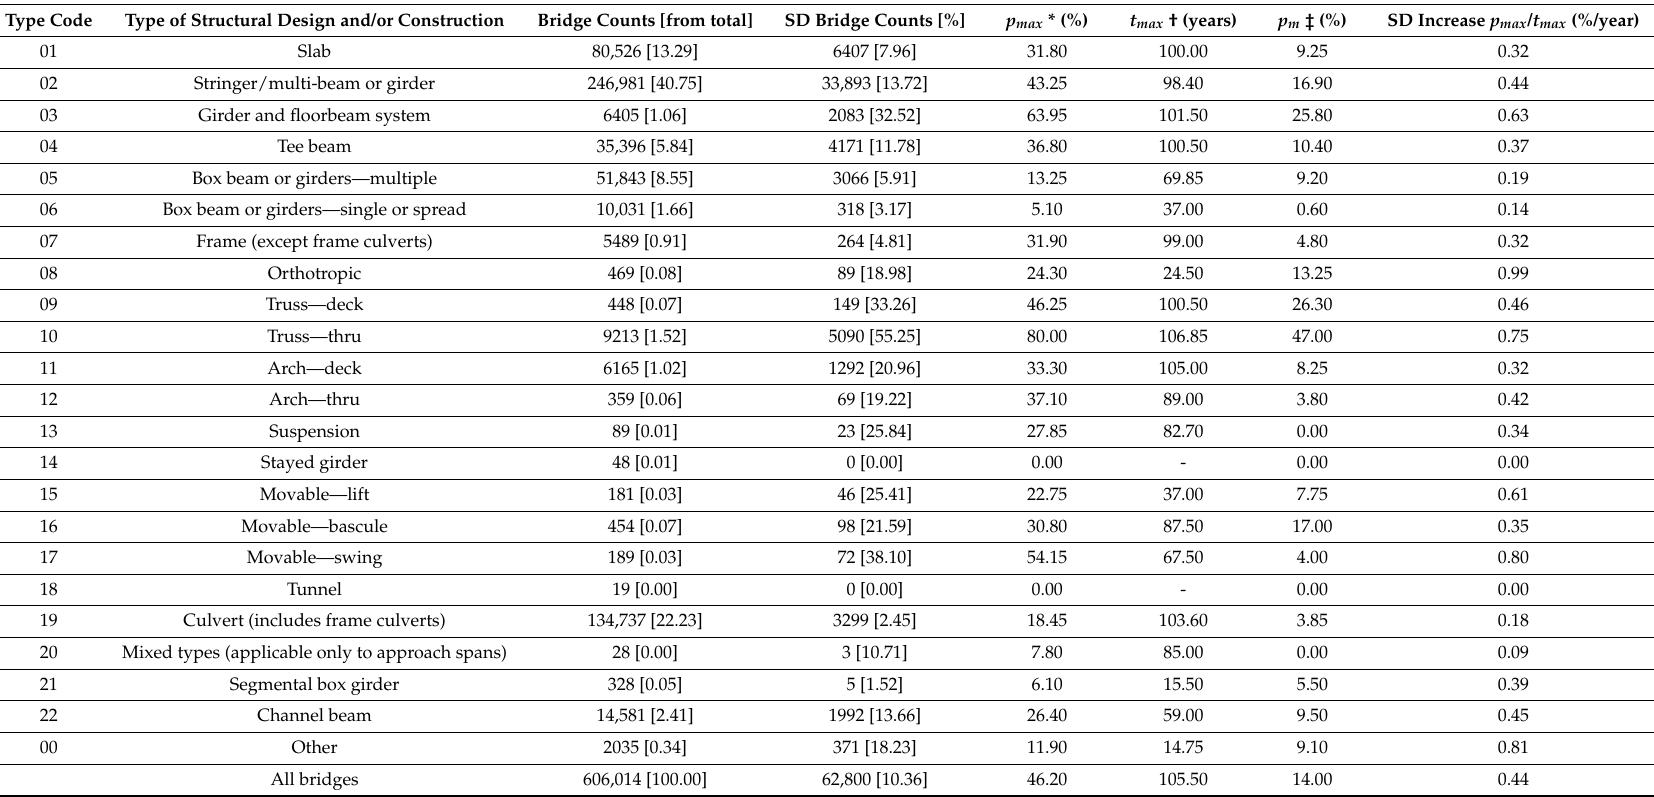
Table 1. Counts of predominant type of structural design and/or construction for bridge main